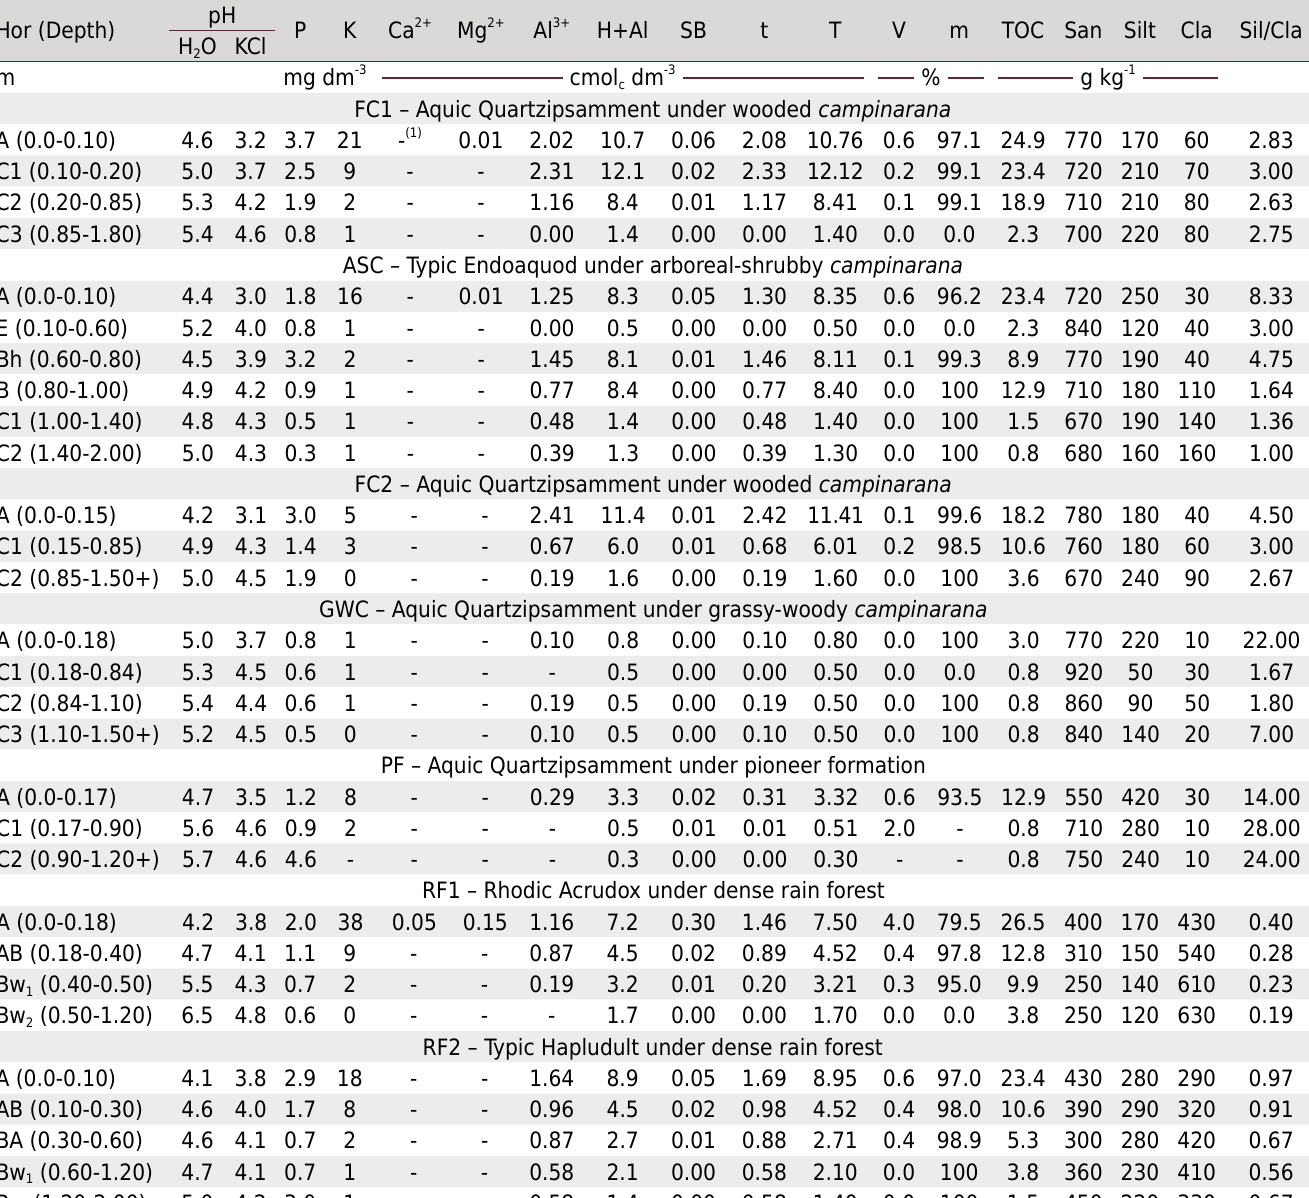
Table 1. Physical and chemical properties of representative soil profiles under the pedoenvironments studied in the Viruá National Park, Roraima,